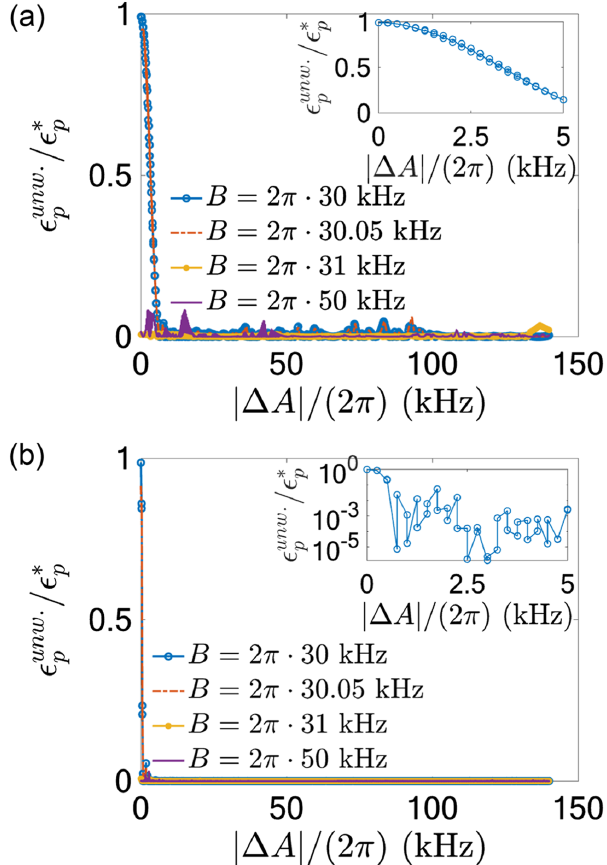
L Þ ¼ 2 = 9 . p ¼ FIG. 13. (a) Unwanted one-tangle (scaled by the maximum 2 = 9 ) for a nuclear spin whose A HF parameter differs value ϵ (cid:3) p ¼ by j Δ A j from the target spin. For the target spin, we consider ð A; B Þ ¼ 2 π · ð 60 ; 30 Þ kHz. The electron is considered to be S ¼ 1 = 2 with electron spin projections s 1 = 2 ¼ − s 0 ¼ 1 . The different colors correspond to different B values for the unwanted spin. The inset shows the unwanted one-tangle in the range j Δ A j = ð 2 π Þ ∈ ½ 0 ; 5 (cid:2) kHz, for the case where the unwanted spin has the same B value with the target one. (b) Similar as (a), but for an electron spin S ¼ 1 , with s 0 ¼ 0 and s 1 ¼ − 1 . In both plots, 2 π · 314 the nuclear Larmor frequency is set to ω L ¼